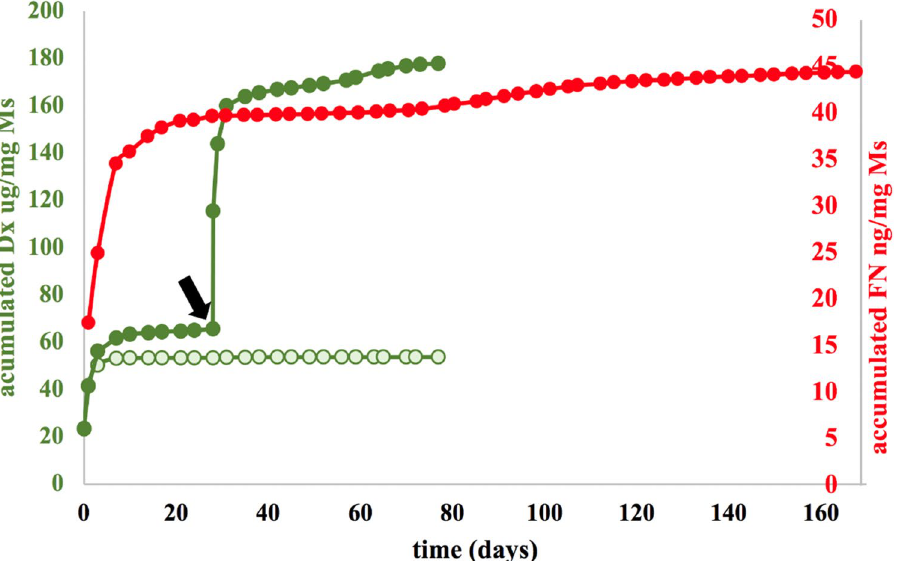
Figure 2. Cumulative in vitro release of dexamethasone (μg/mg Ms) [in green] from Dexamethasone-loaded microspheres [dark green] and Dexamethasone/Fibronectin-loaded microspheres [light green]. Cumulative in vitro release of fibronectin (ng/mg Ms) [in red]. Release media: PBS (pH 7.4 isotonized with NaCl) and 0.02% Na azide. Note : To simulate the in vivo conditions of the animal model obtained by two injections of Dexamethasone-loaded microspheres, a second dose of microspheres was included in the release media at 28 days [black arrow]. DX dexamethasone, FN fibronectin, Ms